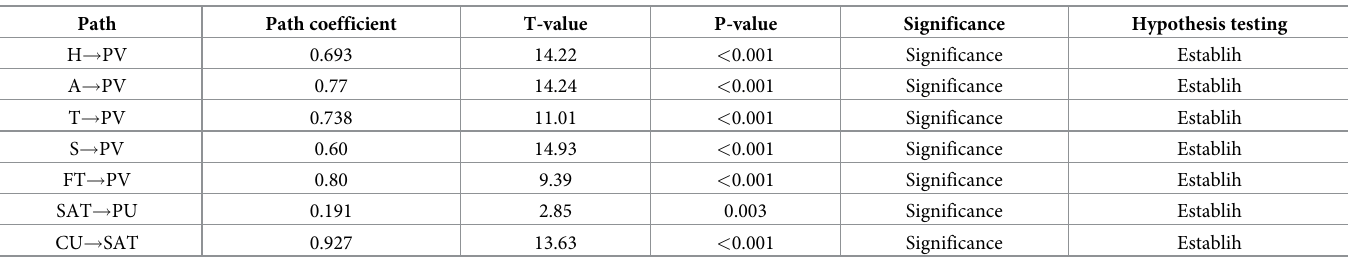
Table 12. Model validation and hypothesis testing.